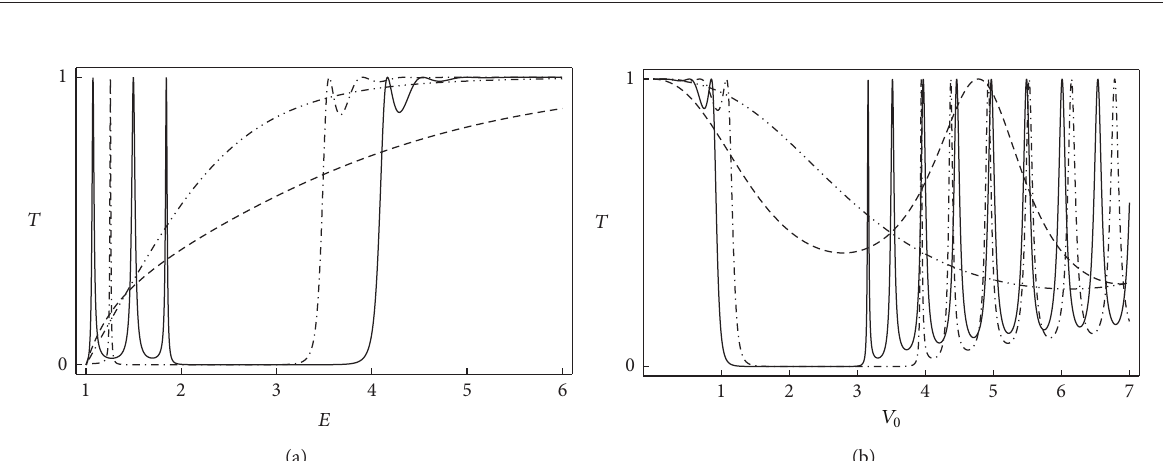
Figure 7: The effect of the potentials for position dependent mass on the transmission coefficient: the GAWSp for 𝑞 = ̃𝑞 = 1.25 , 𝑎 = 𝑏 = 4 , = 1 , and 𝑚 = 0.01 (dot-dashed lines), the Woods-Saxon potential for 𝑞 = ̃𝑞 = 1 , 𝐿 = ̃𝐿 = 3 , 𝑝 = ̃𝑝 = 1 , 𝑚 𝐿 = ̃𝐿 = 3 , 𝑝 = ̃𝑝 = 1 , 𝑚 0 1 ̃𝐿 = 0 , 𝑝 = ̃𝑝 = 1 , 𝑚 0 = 1 , and 𝑚 1 = 0.01 (dash-double-dotted and 𝑚 1 = 0.01 (solid lines), the cusp potential for 𝑞 = ̃𝑞 → 0 , 𝑎 = 𝑏 = 4 , 𝐿 = ̃𝐿 = 0 lines), and the Hulthen potential for 𝑞 = ̃𝑞 = 0.75 , 𝑎 = 𝑏 = 4 , 𝐿 = , 𝑝 = ̃𝑝 = 1 , 𝑚 0 = 1 , and 𝑚 1 = 0.01 (dashed lines). In (a) and (b), parameters are 𝑉 0 = 3 and 𝐸 = 2 ,